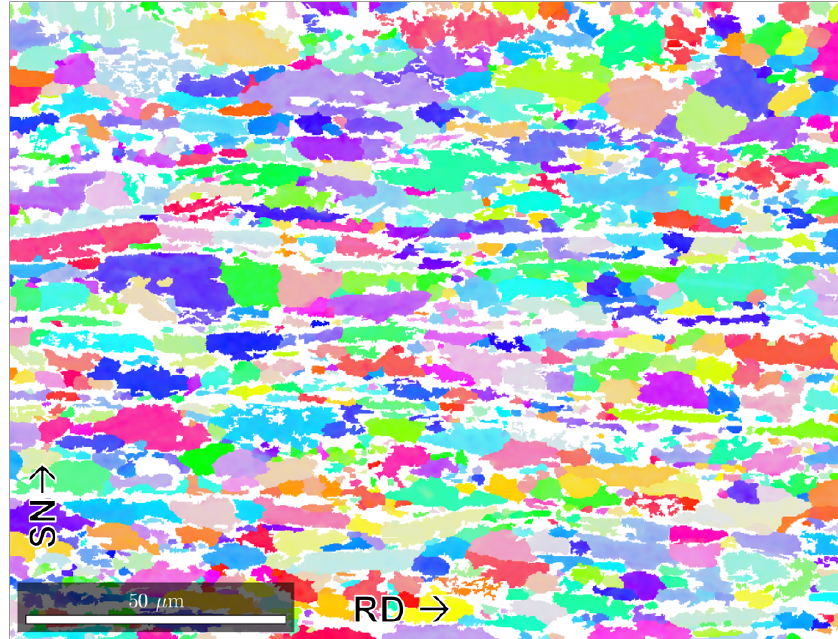
Figure 1. The electron backscatter diffraction (EBSD) of steel DP800 where the x-axis is the rolling direction (RD) and the y-axis is the sheet normal (SN)